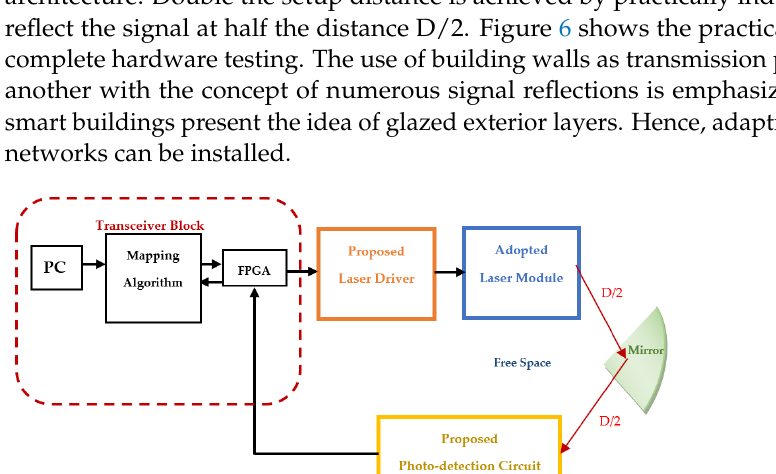
Figure 6. Proposed System Setup.